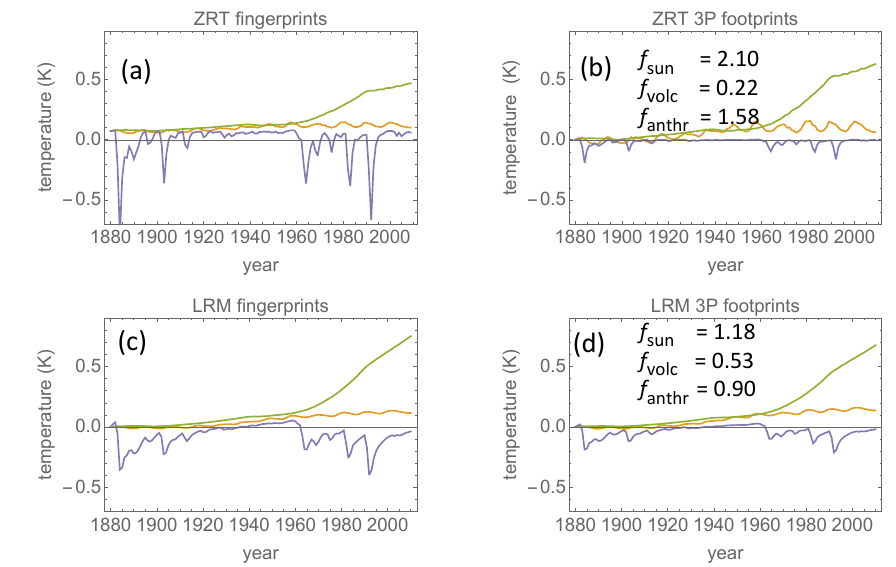
Figure 3. Fingerprints and footprints for the instrumental temperature 1880–2010CE. Panel (a) : the application of Eq. (6) with F being the ZRT filter for the individual forcing components ( F sun ( t ) (yellow), F volc ( t ) (magenta), F anthr ( t ) (green)) to produce the fingerprints S ( t ), V ( t ), and H ( t ) for the ZRT filter. Panel (b) : the footprints f sun S ( t ) (yellow), f volc V ( t ) (magenta), and f anthr H ( t ) (green) of ZRT 3P regressed signal. Panel (c) : the same as in (a) but with the LRM filter. Panel (d) : the same as in (b) but with the LRM